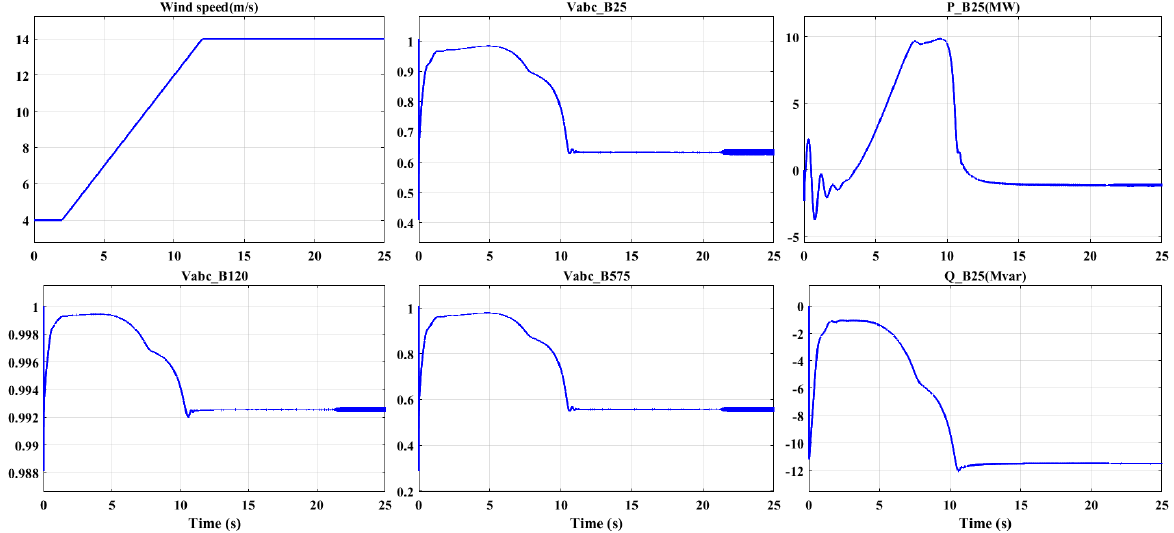
Figure 12. SCIG gird parameters at steady-state operation condition.